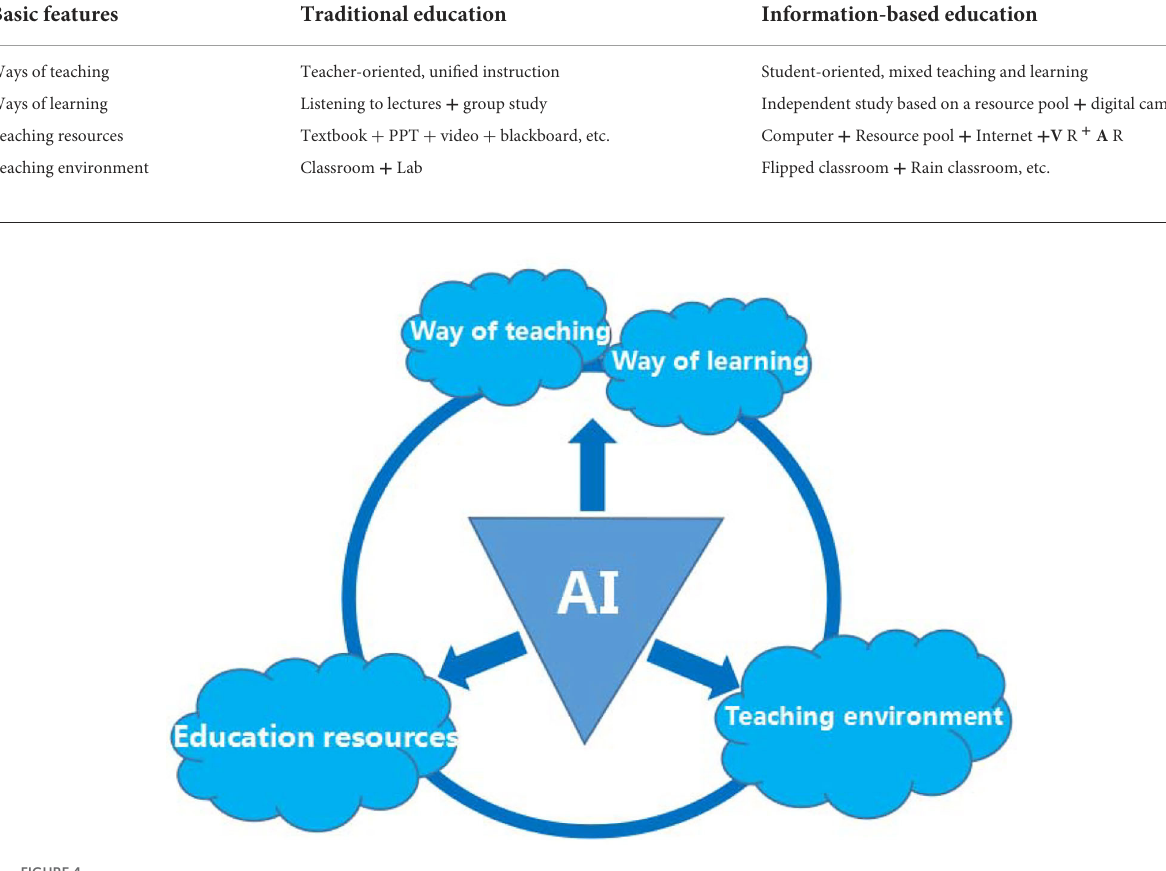
FIGURE4 Framework of artificial intelligence technology for teaching and learning